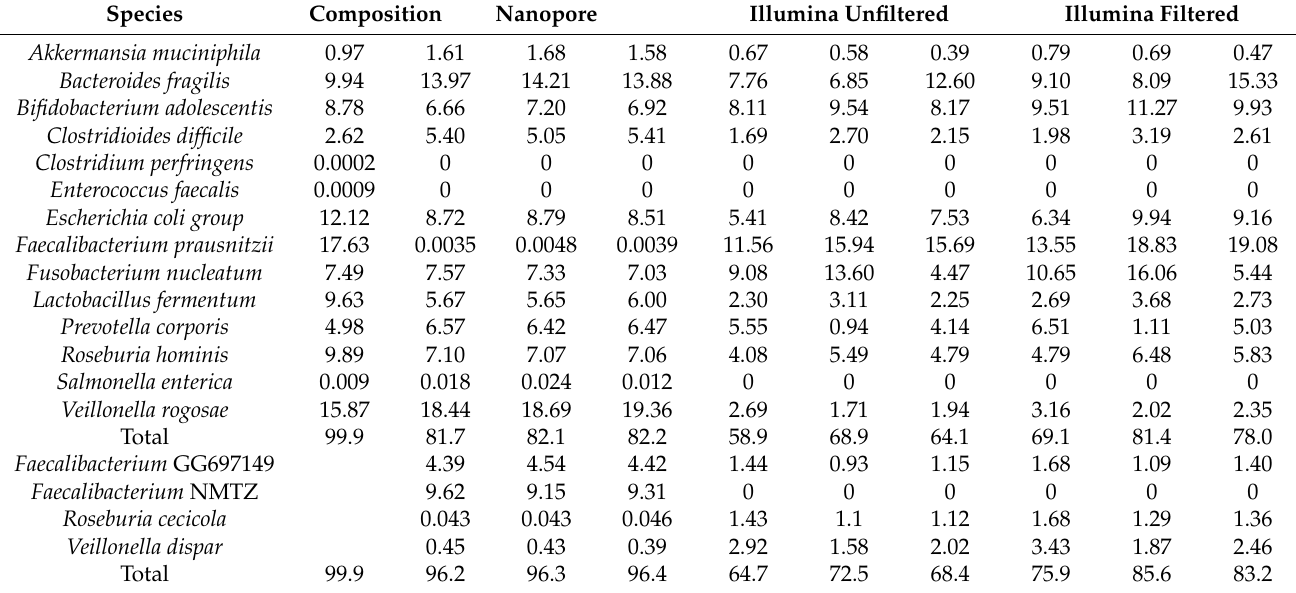
Table 2. The relative abundance (%) of bacterial species in the mock community compared to the Nanopore and Illumina